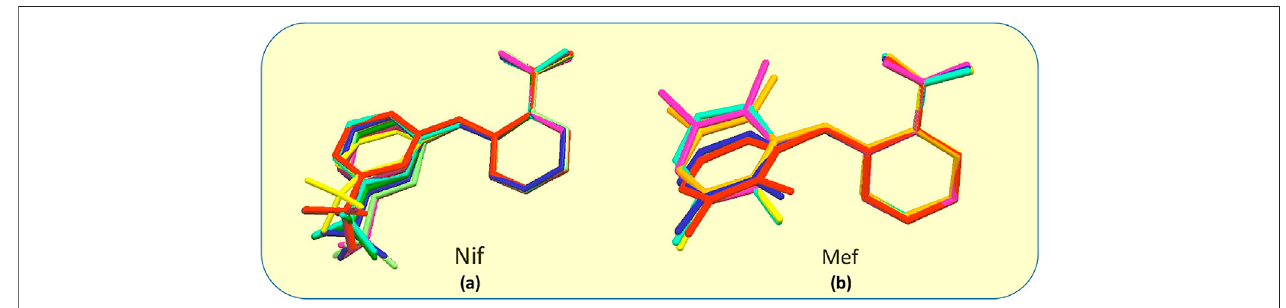
FIGURE 18 | (A) Molecular overlay diagrams of Nif in salts/cocrystals. Color codes: Light blue ‒ Nif, Red ‒ 1 , Orange ‒ 2 , Yellow ‒ 2a , Green ‒ 3 , Cyan ‒ 4 , Blue ‒ 4a , Purple ‒ 5 , Magenta ‒ 6 . (B) Molecular overlay diagrams of Mef molecule in salts/cocrystals. Color codes: Light blue ‒ Mef I, Green ‒ Mef II, Red ‒ 7 , Orange ‒ 8 , Yellow ‒ 9 , Cyan ‒ 10 , Blue ‒ 11 , Purple ‒ 12